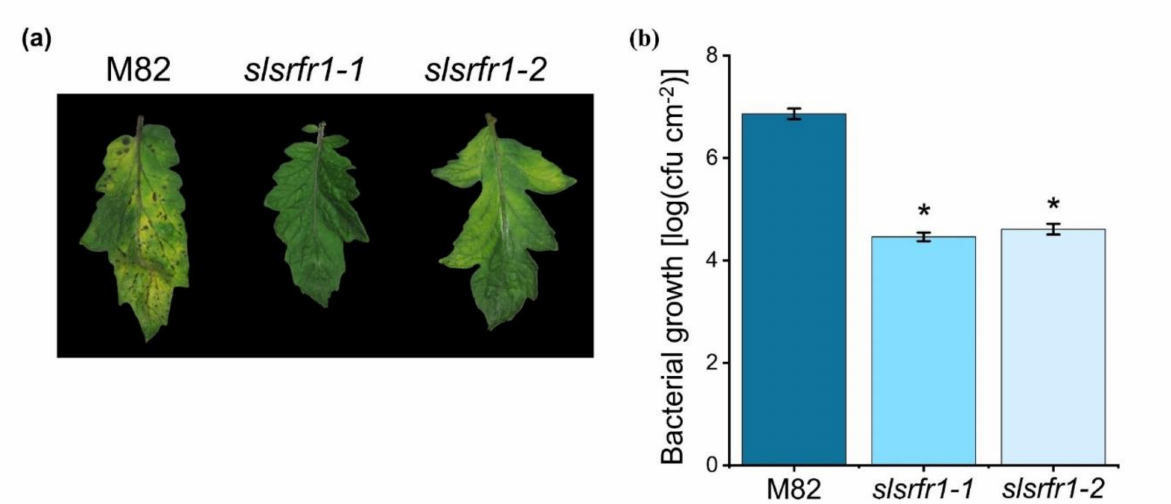
Figure 7. Response of slsrfr1 lines to the bacterial pathogen Pseudomonas syringae pv. tomato DC3000. ( a ) Disease symptoms of parental M82 (left), slsrfr1-1 (middle), and slsrfr1-2 (right) dip-inoculated with Pto DC3000. Disease symptoms (leaf chlorosis) were recorded at 5 DPI. Only the fourth trifoliate leaflet of the plants was inoculated; ( b ) in planta bacterial growth was measured in indicated plant lines on day 5 after inoculation with Pto DC3000 at a density of 2 × 10 8 cfu/mL. Values represent averages of cfu/cm 2 leaf tissue from four replicas, and error bars denote standard deviation. Asterisks indicate that the growth of DC3000 was significantly different between M82 and slsrfr1 mutants as determined by a two-tailed Student’s t -test (* p < 0.01). This experiment was repeated twice with similar